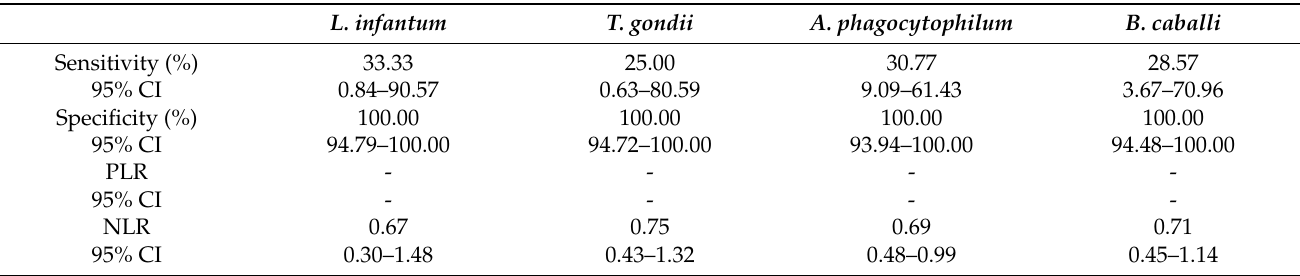
Table 3. Sensitivity, specificity and negative likelihood ratio (NLR) of aqueous humor, when cut off values are the same with those that used for the serum.